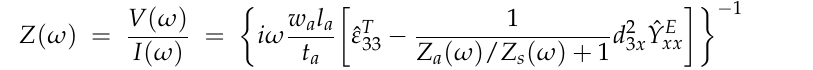
ˆ where is the complex Young’s modulus of the PZT patch at zero electric ˆ T field; is the complex dielectric constant at zero stress; the parameters η xx and δ are structural damping loss factor and dielectric loss factor of the PZT, respectively; d 3 x is the piezoelectric coupling constant in x -direction at zero stress; and w a , l a , and t a are the width, length, and thickness of the PZT, respectively. From Equations (1) and (2), it is